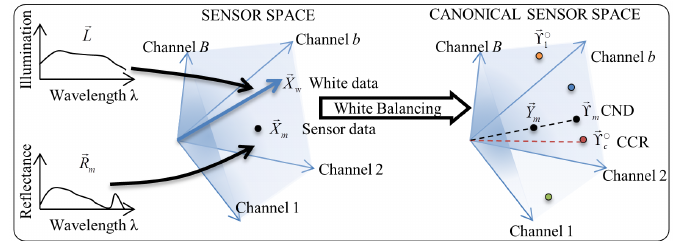
Figure 6. Illustration of the process of classification of the data using the lookup